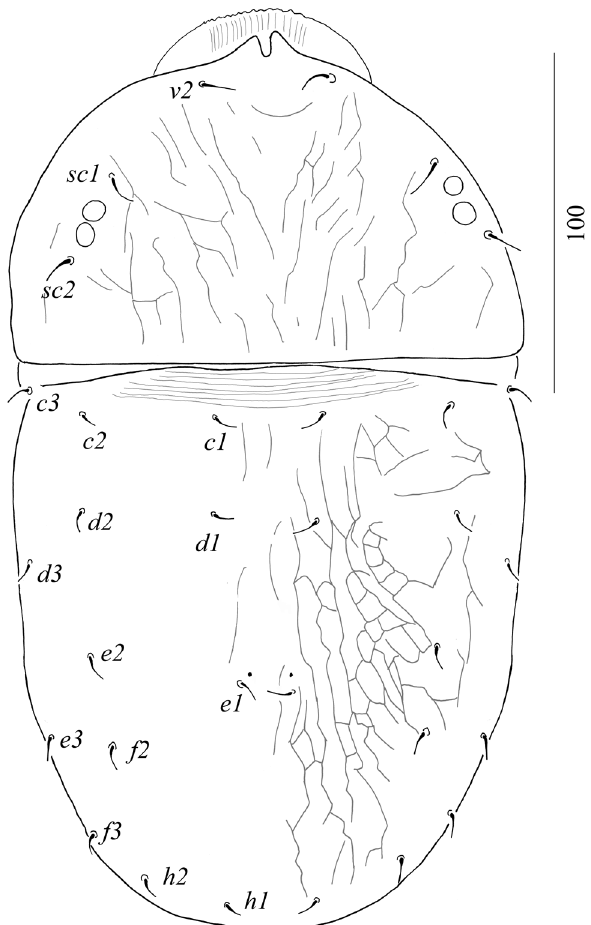
Figure 1. Dorsal view of Aegyptobia bozaii sp. n., holotype, female. smooth and simple; seta f2 present. Length of dorsal setae 6–14. Dorsal opisthosomal pores close to e1 . Rostrum extending to middle of tibia I. Genital flap smooth. Inter- coxal area between 3a and 4a smooth. Description (females; n = 6). Idiosoma reddish-brown (Figure 27), oval in shape, body measured from v2 to h1 240–245; from tip of rostrum 260–266; width 143–147 near setae sc2 ; distance between setae sc2 120–125; length of legs I–IV (without coxa), leg I 105–110, leg II 80–87, leg III 72–78, leg IV 80–88. Dorsum (Figure 1): Anterior margin of prodorsal shield with paired projections, depth of notch 7–8. Propodosoma finely lineate. Opisthosoma with polygonal reticu- lations; polygons longitudinally elongate medially, transversally elongate anterolater- ally. Propodosomal and opisthosomal setae simple and smooth. Opisthosomal pores present close to e1 . Prodorsal setae v2 shorter than half distance between their